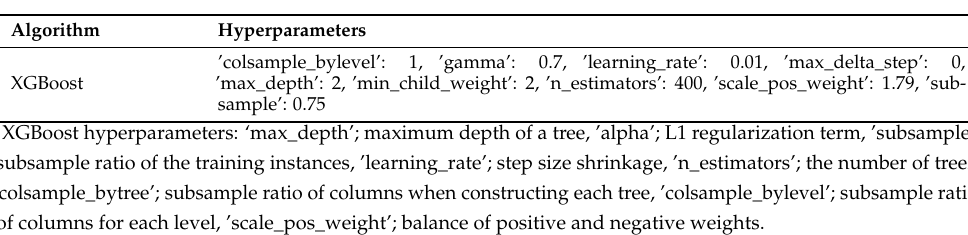
Table A6. Hyperparameters of XGBoost supervised classification machine learning model that predicts complete cytoreduction using the new intraoperative score.